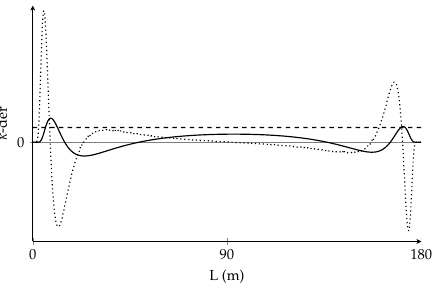
Figure13. Plotsofthe1stderivativeofthecurvaturefortheclothoid(dashed)anddefaultERB-function Figure 13. Plots of the first derivative of the curvature for the clothoid (dashed) and default blendingsplines,withlocalarccurves,in [ p 3 , q 3 ] (solid),andthe2ndderivativeofthecurvaturefor theblendingspline,scaledby 1 10 (dotted). ERB-function blending splines, with local arc curves, in [ p 3 , q 3 ] (solid), and the second derivative Fromthepreviousresultsanassumptioncanbemadethatanyblendingsplinewithasmoother 246 of the curvature for the blending spline, scaled by 1 10 curvaturediagramtowardstheendpoints,thanthedefaultERB-funtionblendingspline,willmeet 247 allthecriteriainSection3.3. Thus,thefocusofthediscussionwhenvaryingERBparameterswillbe 248 onsmoothingthecurvaturealongtheblendingspline. IntheadjustmentoftheERBparameters,the 249 curvesthatarestudiedhaveentrypoints [ p 3 , q 3 ] . 250